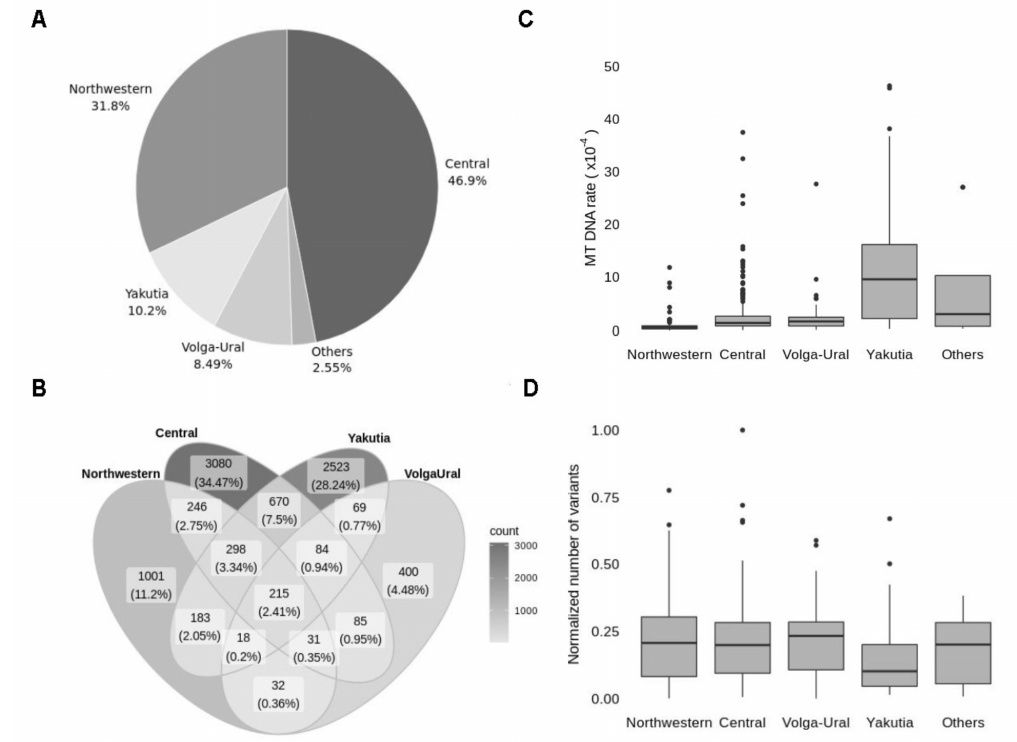
Figure 5. Geographic origin of explored samples. ( A ) Distribution of samples according to geographic region (Others include Southern, Far Eastern and North Caucasian regions, presented with a minor fraction of samples). ( B ) A Venn diagram representing the intersection between sets of variants in four regions: Northwestern, Central, Volga-Ural and Yakutia. Figures represent the number of distinct variants in every section and the percentage of the total number of variants. ( C ) Distribution of samples in every region according to mtDNA content. ( D ) Distribution of samples in every region by the number of variants, normalised to mtDNA